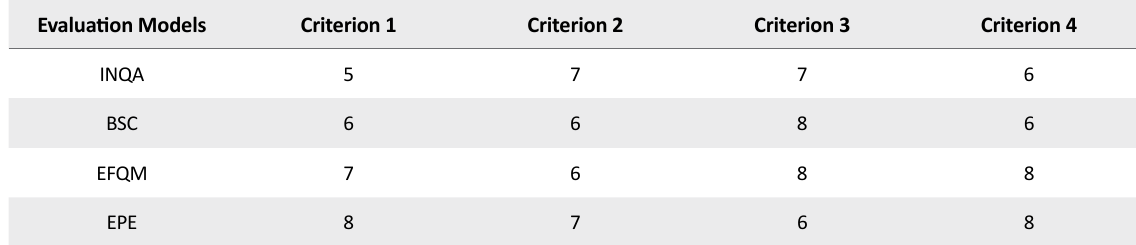
Table 3. The index score of four criteria to evaluate research models Evaluation Models